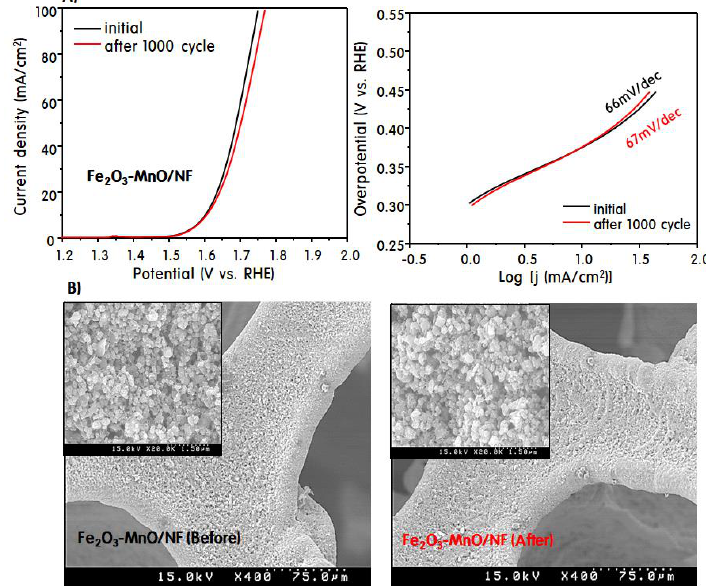
Figure 5. LSV curves at 1000 cycle for the OER ( A ) and SEM images of the electrode surface before and after the 1000 cycled OER ( B ). after the 1000 cycled OER ( B